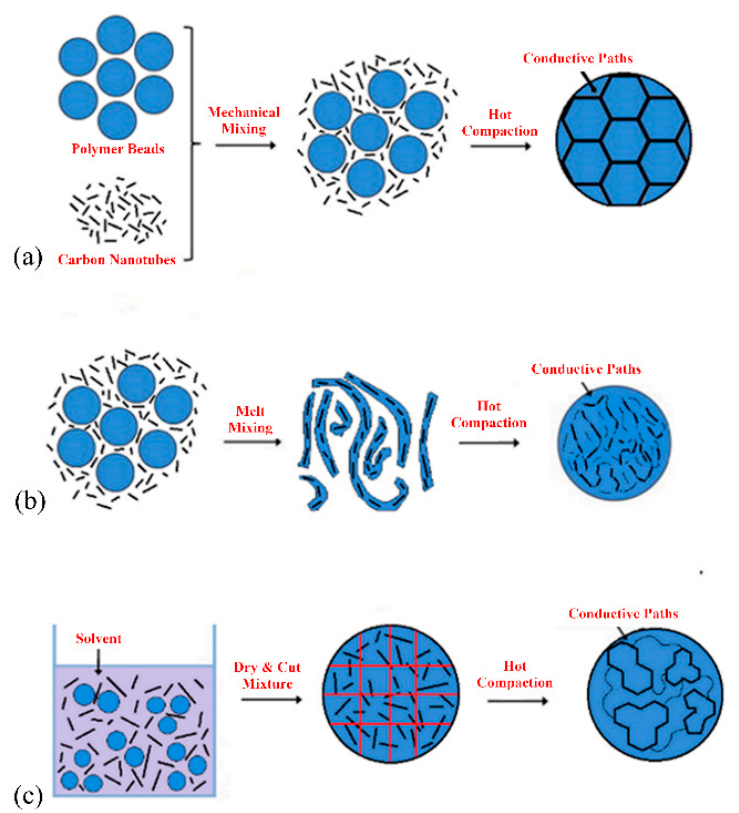
Figure 2. Schematics of particle processing methods used to make polymer-CNT composites. ( a ) mechanical mixing; ( b ) melt mixing; ( c ) solution mixing [9].